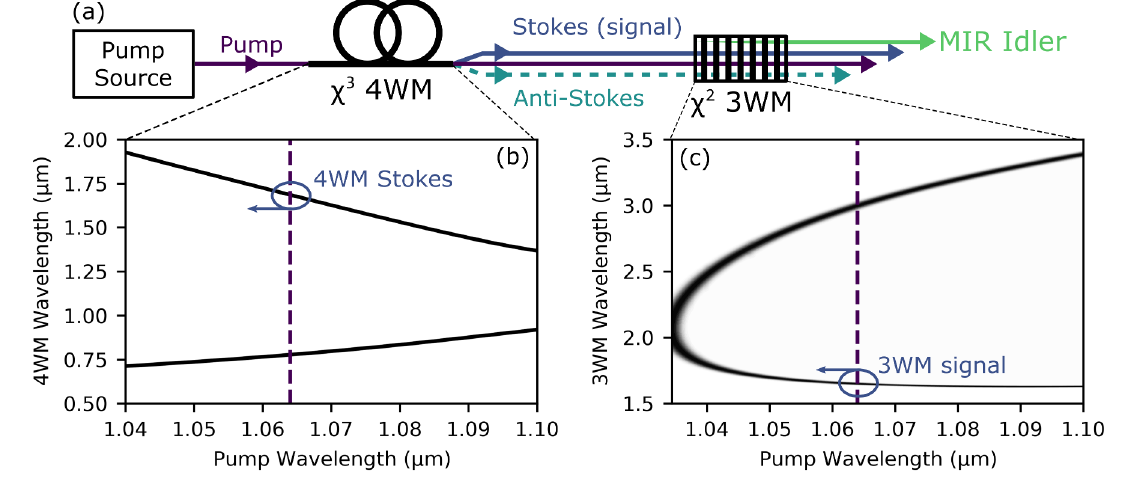
Figure 1. (a) Schematic of MIR generation via cascaded χ (3) 4WM in fibre and χ (2) 3WM in a bulk non-linear crystal. (b) Phase matching diagrams for the 4WM in PCF and (c) 3WM in PPLN (at 60 ◦ C). Circles highlight the common wavelength which is phase matched in both the 4WM and 3WM interactions.